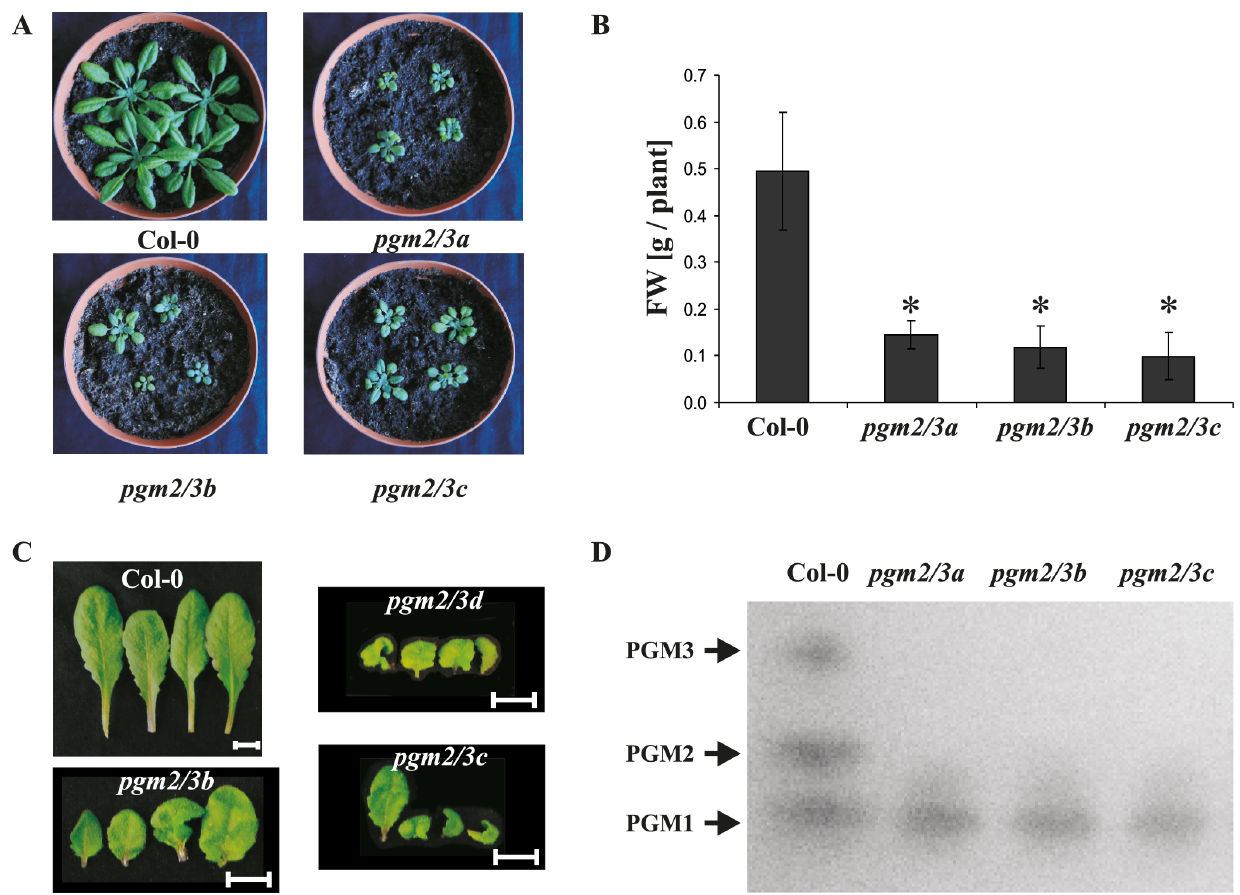
Figure 1. Phenotype of Col-0 and pgm2/3 plants in 12 h light/12 h dark regime. A, Growth phenotypes. Photographs were taken of six- week-old plants. Bar=1 cm. B, Fresh weight of plant rosettes. Values are means 6 SD (n=29 2 30). Plants were harvested after five weeks. Asterisks indicate significant difference from Col-0 (Student Test, P # 0.01). C, Leaf form from Col-0 and transgenic plants. Leaves were harvested from the middle of rosettes from six-week-old plants. Bar=1 cm. D, Phosphoglucomutase activity in Col-0 and pgm2/3 plants. Crude extracts were subjected to native PAGE and subsequent PGM activity staining. Separation gel was 7.5% [T] and 25 m g protein was loaded per lane.